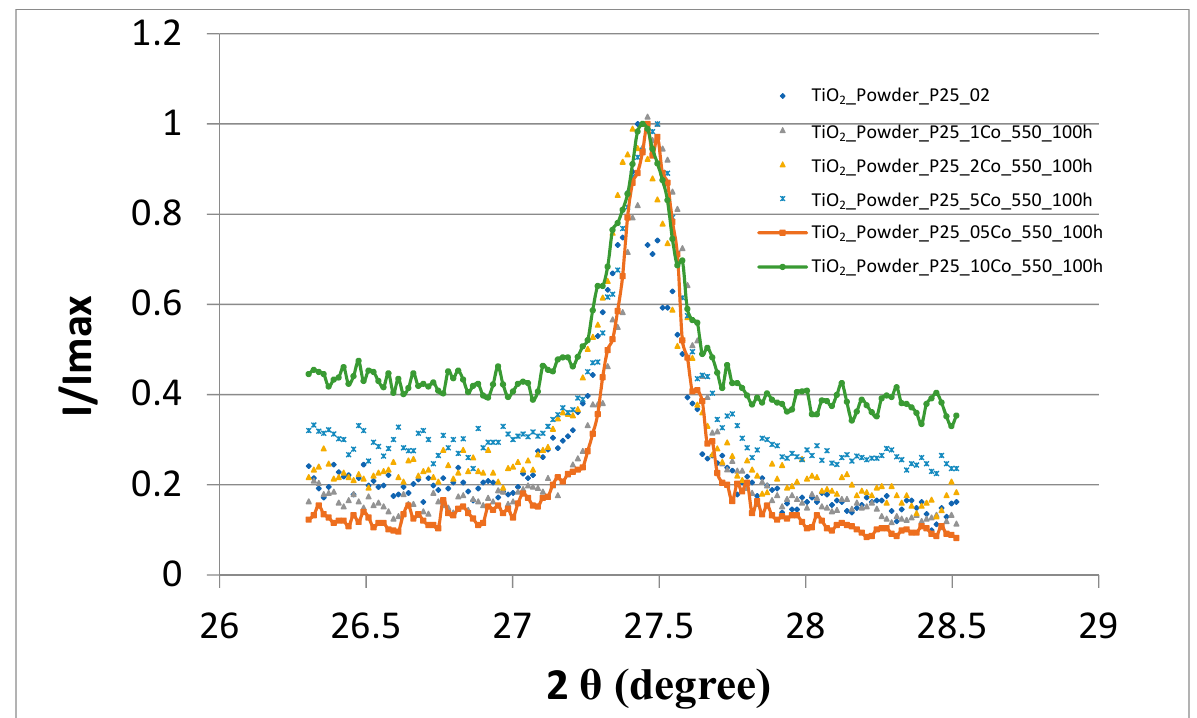
Figure 4. XRD peak ((110)—rutile) patterns of TiO 2 Degussa P25 powders doped with Co.